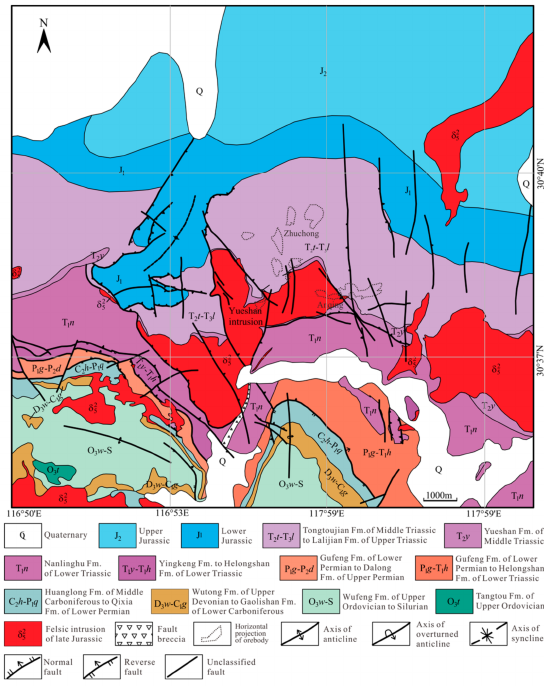
Figure 1. Geological map of the Anqing orefield, modified after Liu et al.